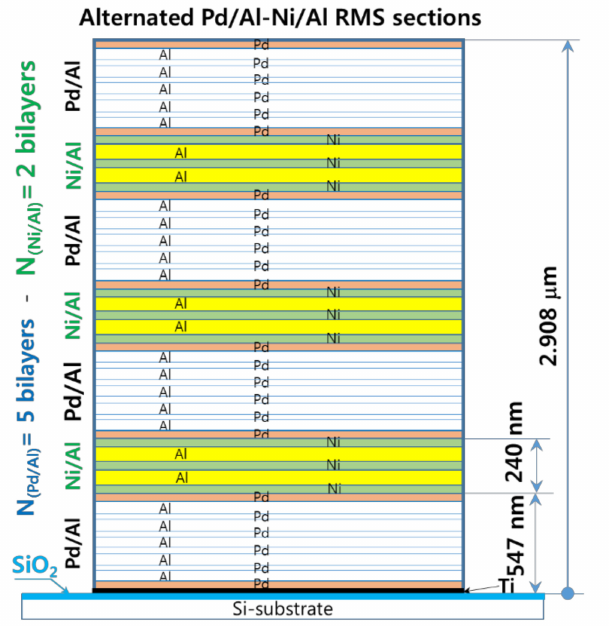
Figure 14. A cross-sectional schematic of the Pd/Al-Ni/Al MS-RMS design showing alternating sections of reactive materials with the corresponding section thicknesses. Design parameters: Pd(47 nm)/Al(53 nm) 5 bilayers, Ni(40 nm)/Al(60 nm) 2 bilayers, Pd/Al-section thickness S hRMS = 500 nm (4 sections) and Ni/Al-section thickness S mRMS = 200 nm (3